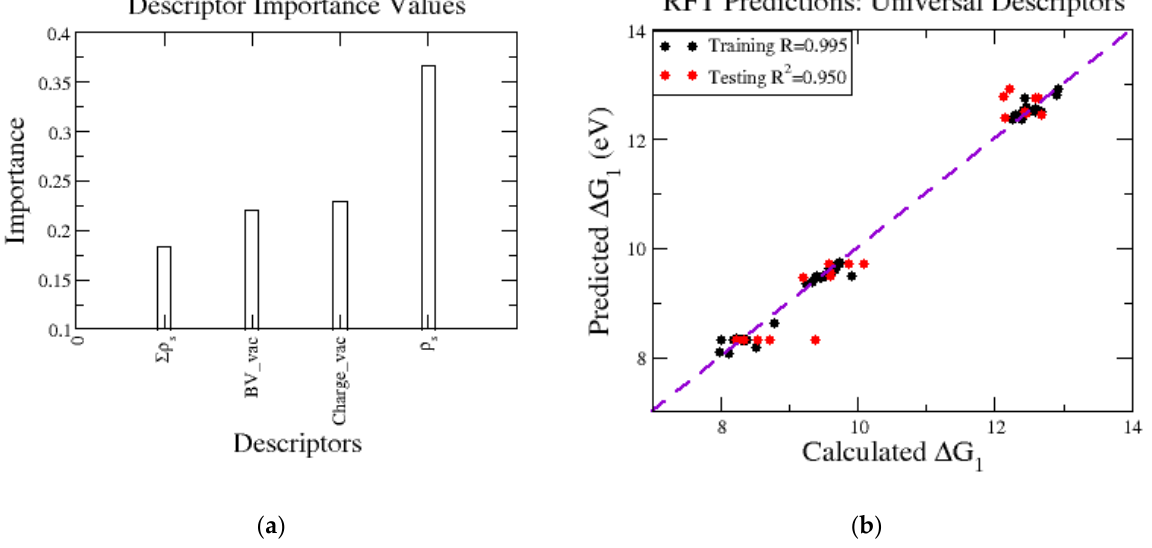
Figure 7. ( a ) Importance values calculated through the RFT model for the descriptors used in training the model from left to right: sum of the magnetic moments of six neighboring metals to vacancy site, Σ ρ s , bond valance sum of the removed metal, BV_vac, the number of valance electrons that the vacancy metal has, Charge_vac, and the magnetic moment of the vacancy site, ρ s . ( b ) Δ G 1 predictions of RFT model with the training data set shown in black and the testing dataset shown in red.